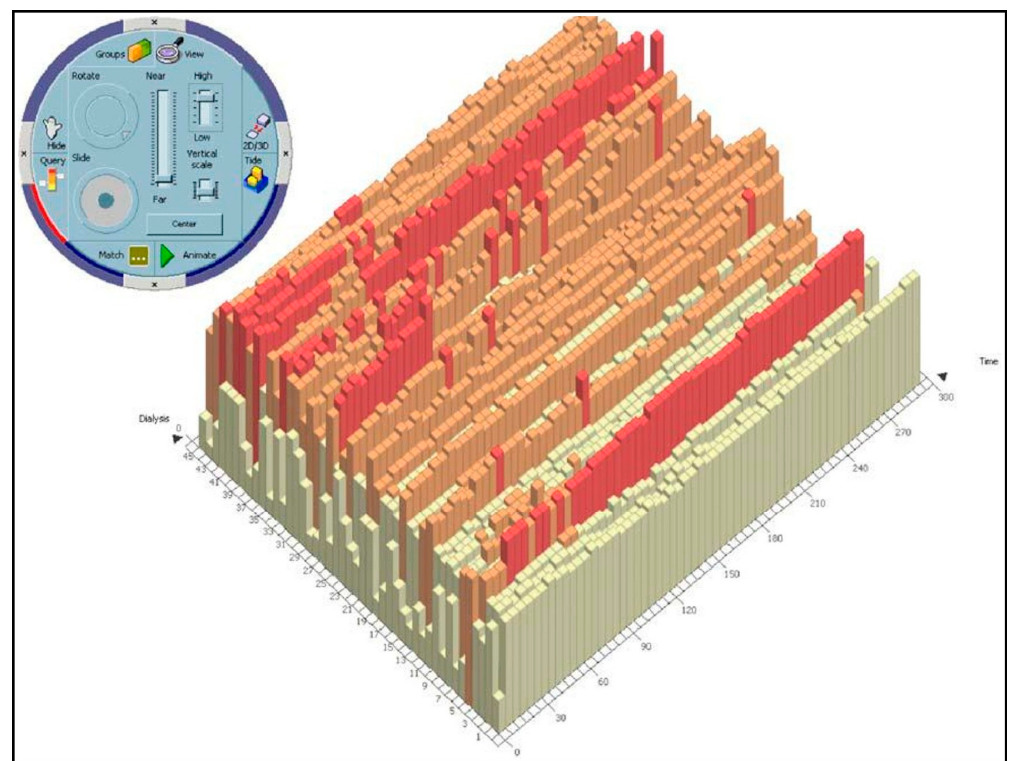
Figure 10. IPBC: 3D visualization tool for analysis of numerical data from multiple hemodialysis sessions. Source: reprinted from Journal of Visual Languages & Computing, 14, Chittaro L, Combi C, Trapasso G, Data mining on temporal data: a visual approach and its clinical application to hemodialysis , 591-620, Copyright (2003), with permission from